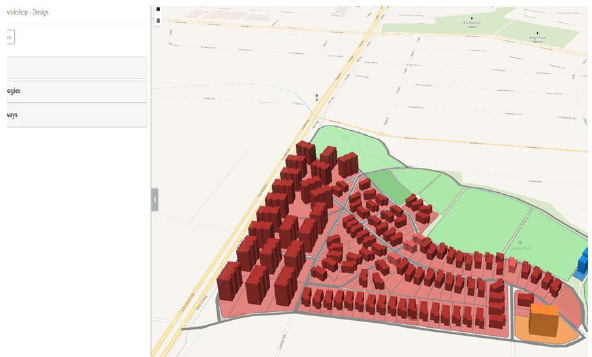
Figure 4. Design scenario for Blacktown City that was developed using ESP